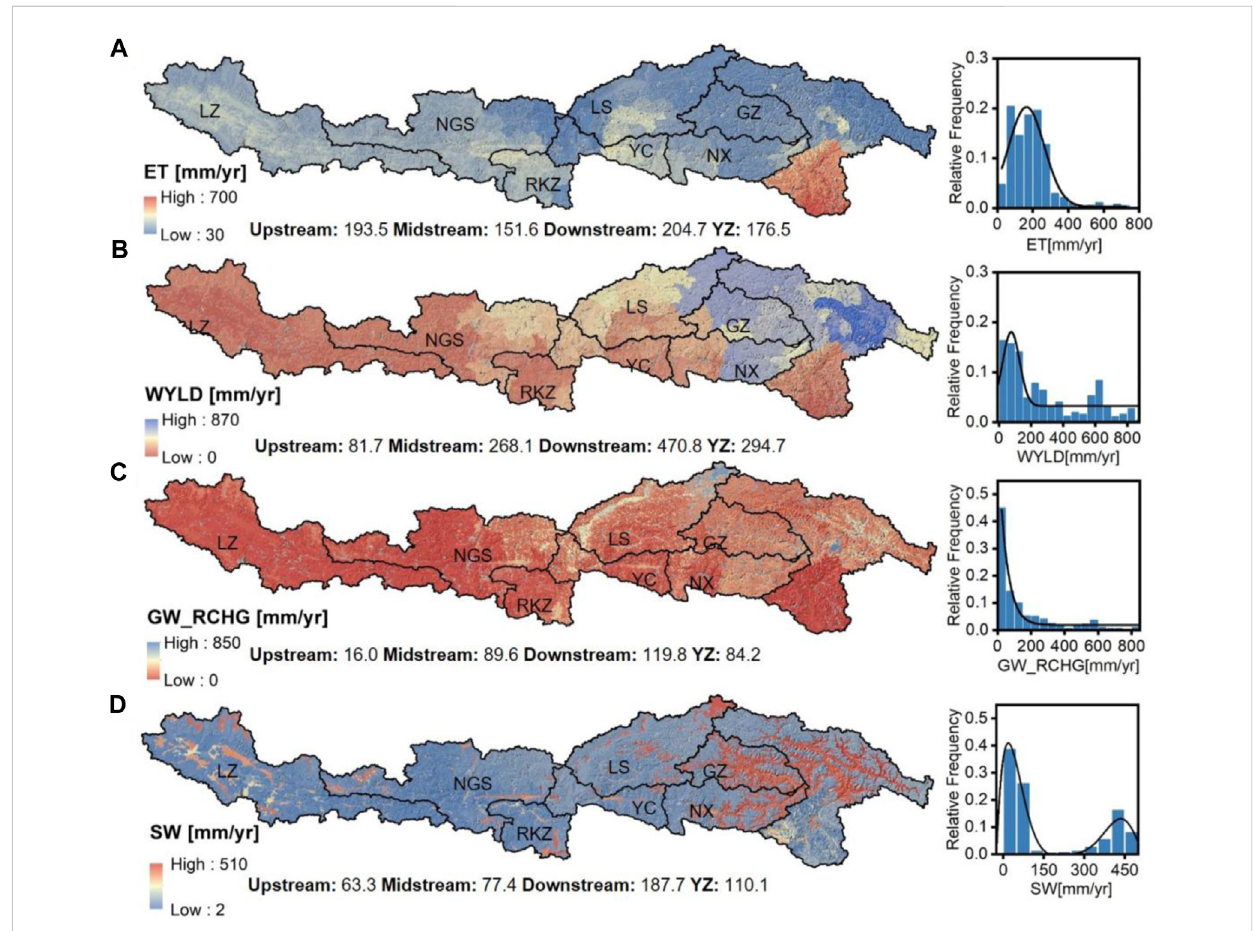
FIGURE 7 Spatial distribution of (A) evaporation (ET), (B) water yield (WYLD), (C) groundwater recharge (GW_RCHG), and (D) soil water content (SW) in the historical period (1980 –